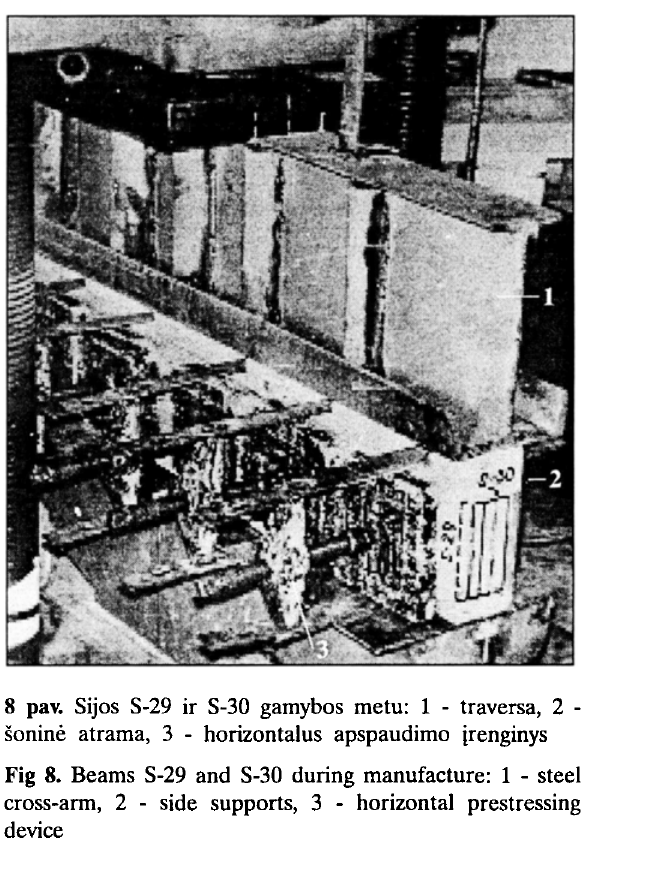
Fig 8. Beams S-29 and S-30 during manufacture: 1 - steel cross-arm, 2 - side supports, 3 - horizontal prestressing device 9-22% pagal sij4 apspaudimo dydj (atitinkamai cry= 1,5-2,25 MPa). Sij4 suirimo momentu tangentiniai jtemptai sijose su isankstiniu jtempiu ( 'tu) buvo vidutiniskai 9-10% didesni negu toki4 pat sij4 be isankstinio jtempio ( t~ ).